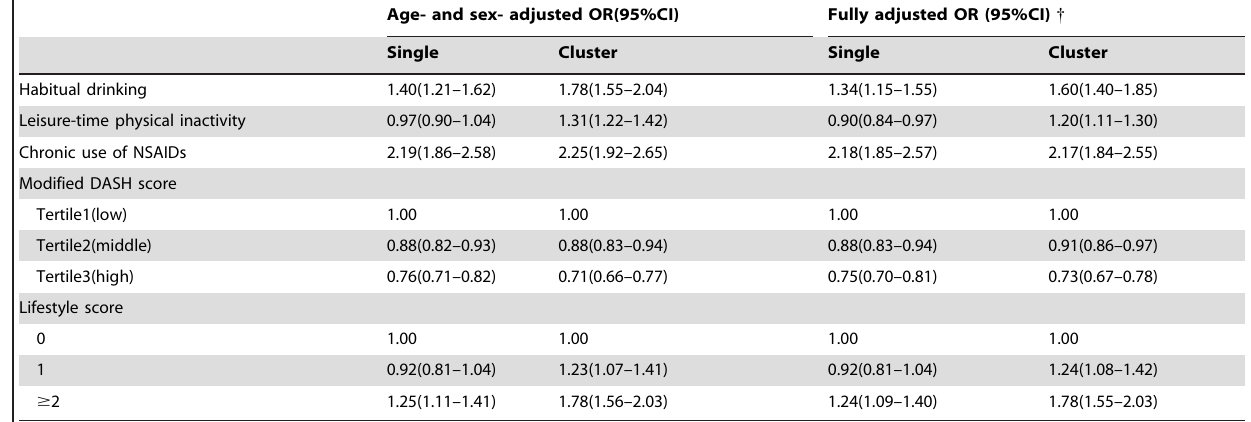
Table 2. Clustering of four major CVD risk factors and lifestyle risk factors. *